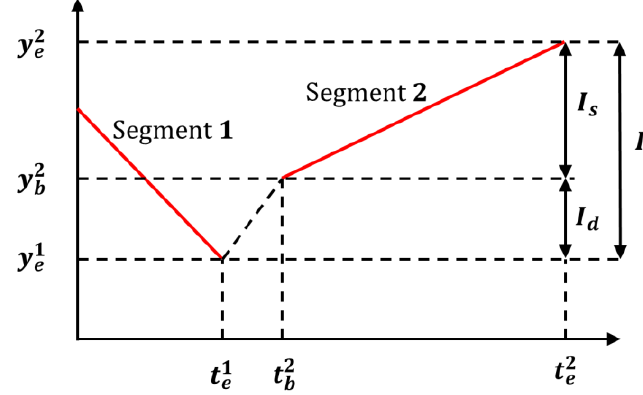
Figure 4. The linear segments in the local moving window.